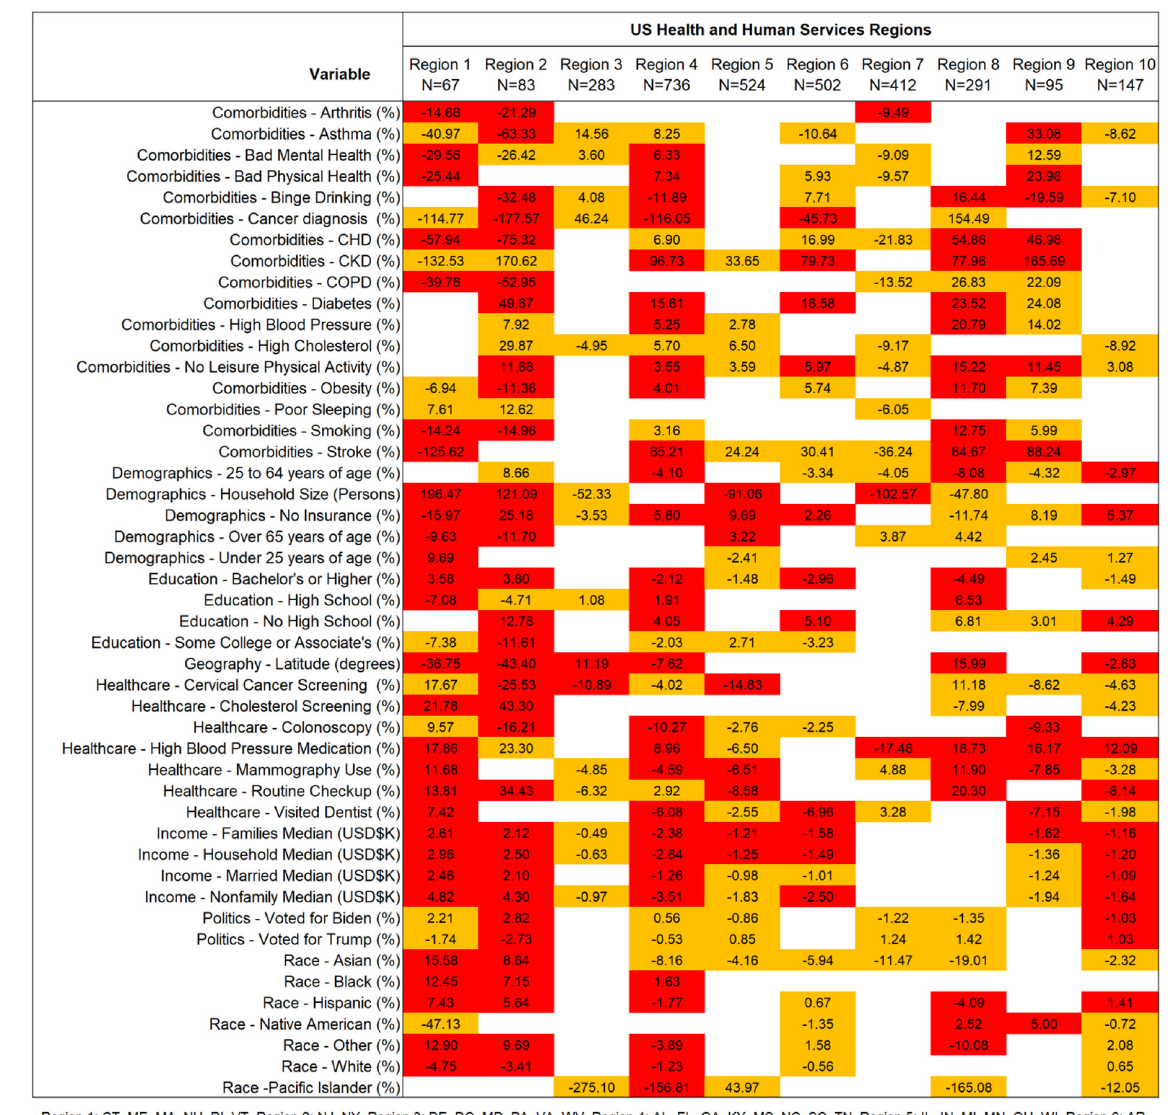
FIGURE2 Regional risk ratio estimates for comorbidity, sociodemographic and determinants of health in association to COVID-19 case-fatalities. All models were performed independently by region and are adjusted to CCVI. Sample sizes correspond to the number of counties in the analysis for each region. Estimates signs indicate effect direction. Red boxes are significant to a Bonferroni level (470 tests P adj ≤ 1.06E-04). Orange boxes are significant to a 95% confidence level. COPD, Chronic Obstructive Pulmonary Disease; CKD, Chronic Kidney Disease, CHD, Coronary Heart